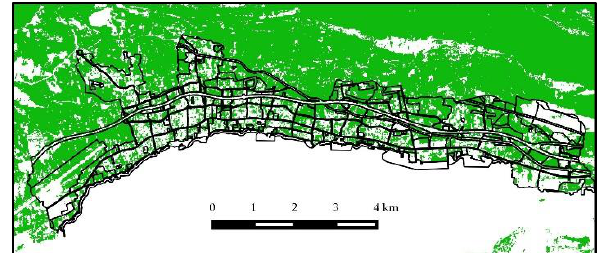
Figure 9. Overlap of vegetation for 2019 with land use